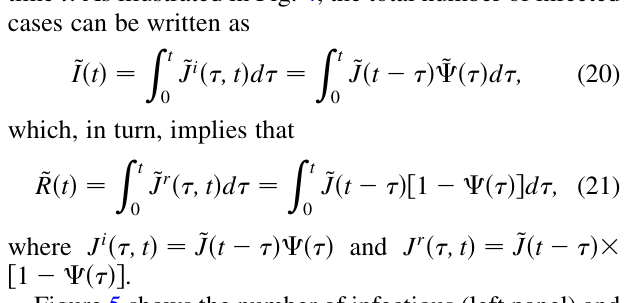
the rate of new infections, Only a fraction of the cases infected at time t (cid:2) (cid:2) , contributes to the infections at time t , (red curve); the rest, already been